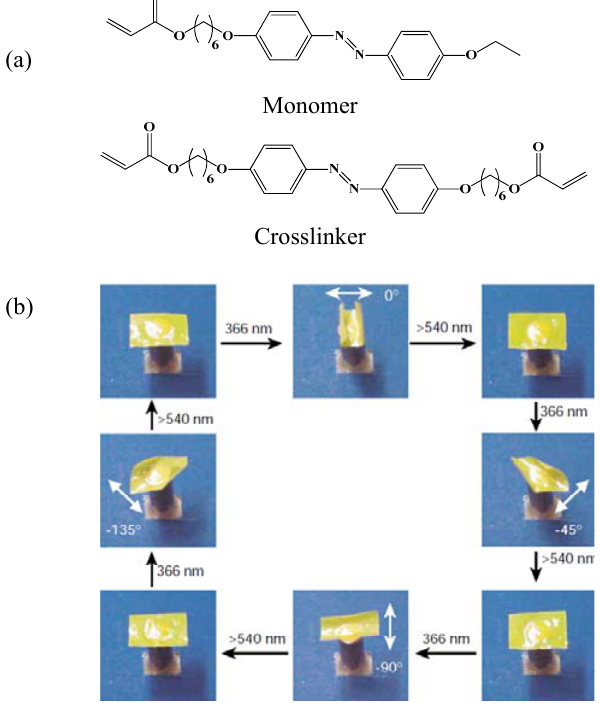
Figure 13. ( a ) Chemical structure of monomer and crosslinker used in the synthesis of LCN films. ( b ) Photographs of direction controlled bending of polydomain LCN film by irradiation with linearly polarized UV light (366 nm) at different angles of polarization. The bent films reverted back to initial flat state by irradiation with visible light (540 nm). Reprinted with permission from Macmillan Publishers Ltd. [Nature] [53], copyright